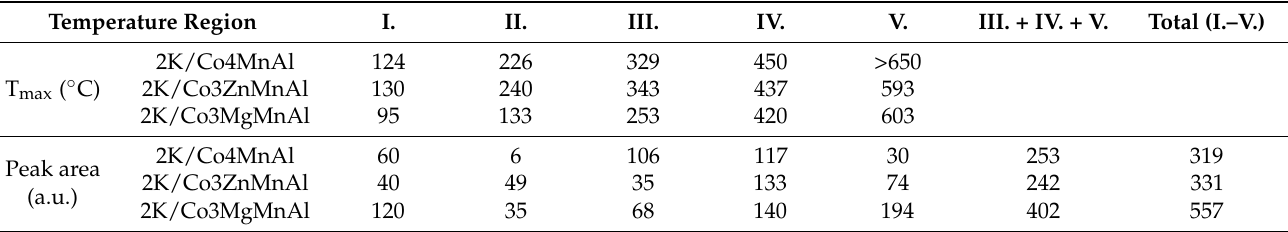
Table 6. Temperature maxima and peak areas obtained from TPD-CO 2 measurements.